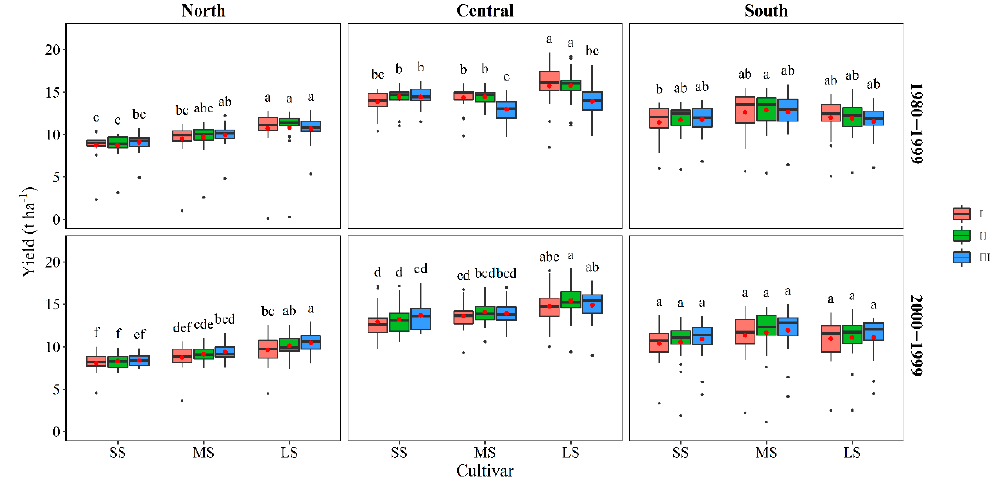
Figure 7. Simulated grain yield based on APSIM for different sowing dates and cultivars. The red dots represent the average yield, the black line shows the median yield. North: Keshan station; Central: Gongzhuling station; South: Shenyang station; SS: short-season cultivars; MS: medium-season cultivars; LS: long-season cultivars; I: early sowing date; II: medium sowing date (traditional sowing date); III: late sowing date. Different letters above the boxes are significantly different at the 0.05 probability level.